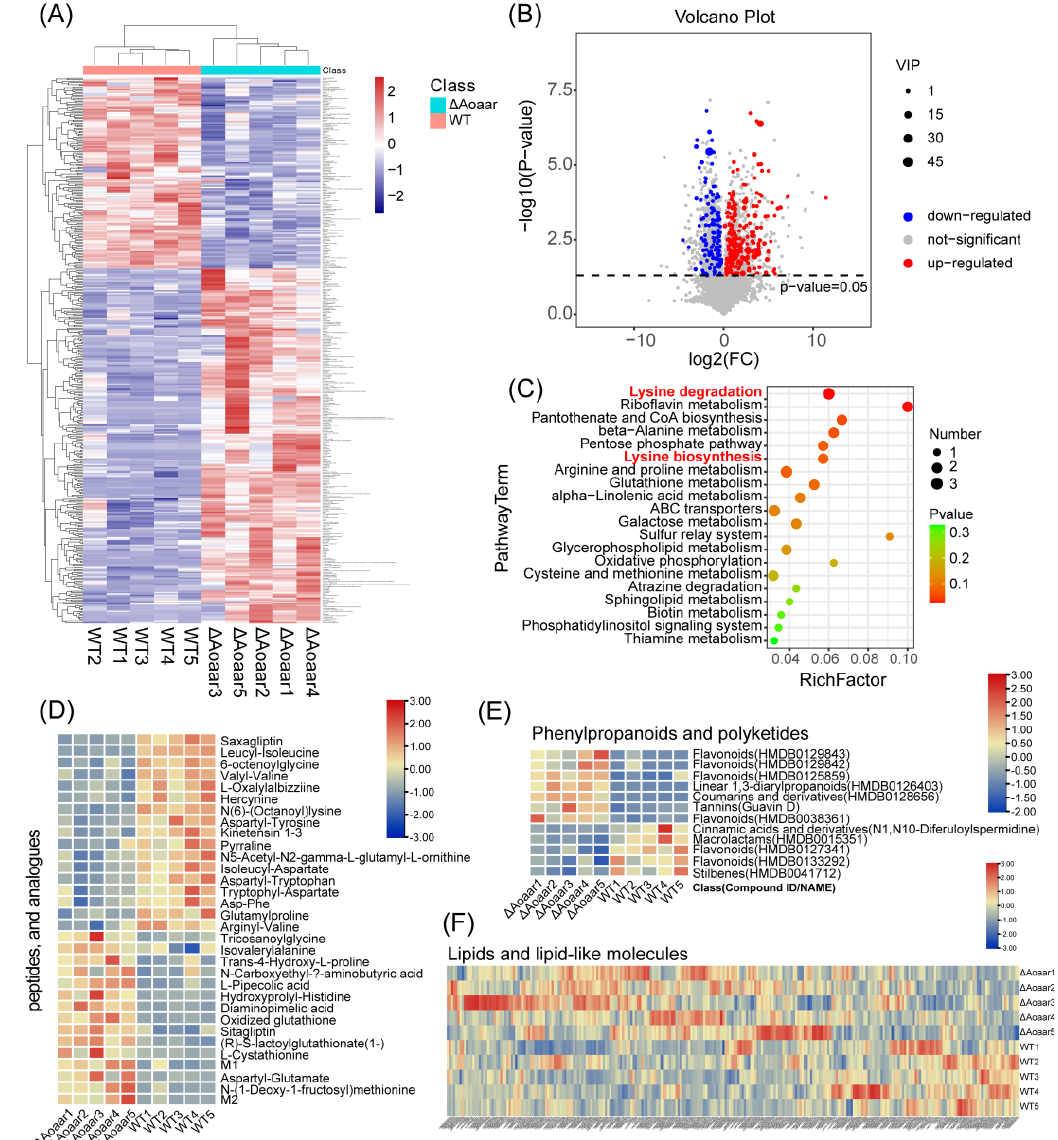
Figure 5. Global metabolic changes between WT and the Δ Aoaar mutant. ( A ) The global metabolite changes are represented as a heatmap. ( B ) Metabolite changes are represented as a volcano plot depicting significant metabolite changes between WT and the Aoaar knockout strain (fold change > 2, p < 0.05, and VIP value > 1). ( C ) Pathway enrichment analysis. ( D ) The differences in peptides and analogues between WT and the Δ Aoaar mutant. ( E ) The differences in phenylpropanoids and polyketides between WT and the Δ Aoaar mutant; ( F ) The differences in lipids and lipid-like molecules between WT and the Δ Aoaar mutant.